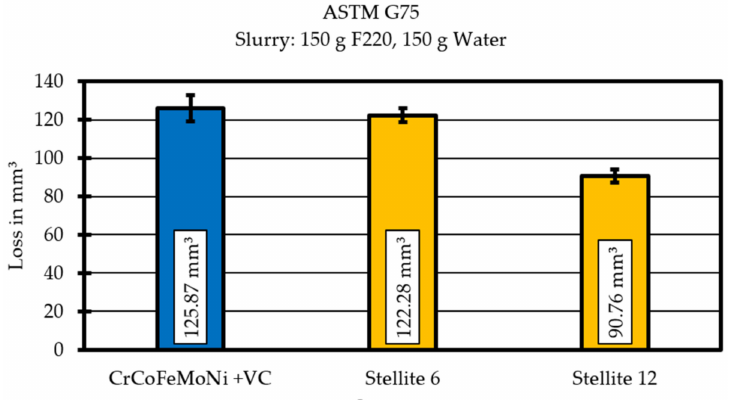
Figure 8. Mass loss for CrCoFeMoNi + VC and Stellite 6 and Stellite